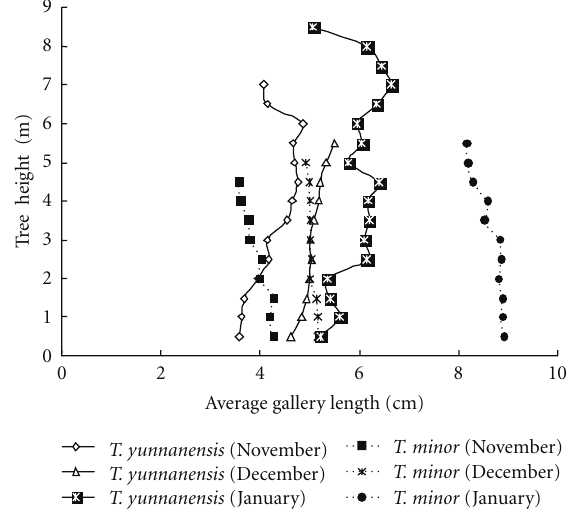
Figure 8: Progression of average egg gallery length of T. yunnanensis and T. minor along the trunks of Yunnan pines from November to January, 2005-2006 (Qujing, Yunnan province,